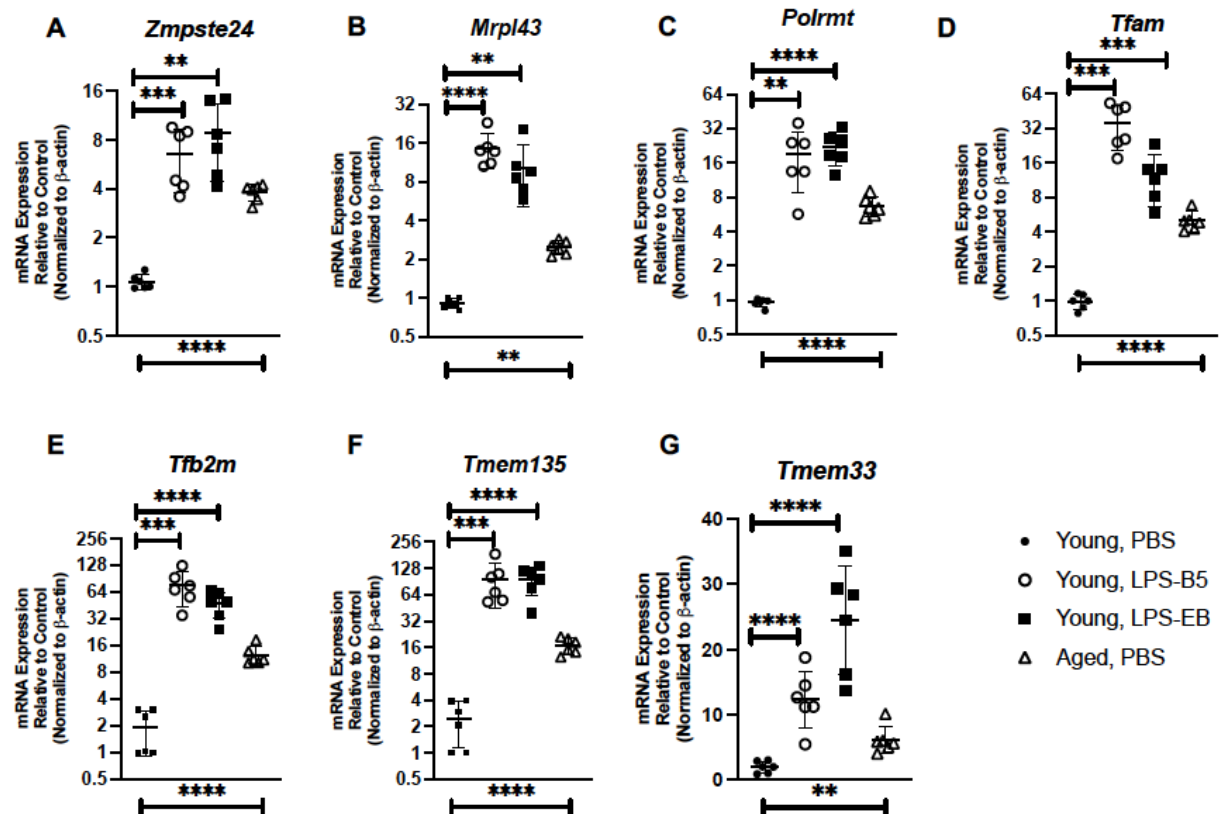
Figure 7. Treatment of Young Mice with Low-Dose LPS Alters Senescence Gene Expression in Lung. Lung tissue was collected from PBS-, LPS-B5-, and LPS-EB-treated young adult BALB/c mice (3 months of age). Expressions of ( A ) Zmpste24, ( B ) Mrpl43 , ( C ) Polrmt , ( D ) Tfam , ( E ) Tf2m , ( F ) Tmem135 , and ( G ) Tmem33 were assessed by real-time PCR. Aged (20 months) PBS-treated lung expression analysis is included for comparison. N = 6 mice per group, and the experiment was repeated 3 times. ** p < 0.01, *** p < 0.001, and **** p < 0.0001.